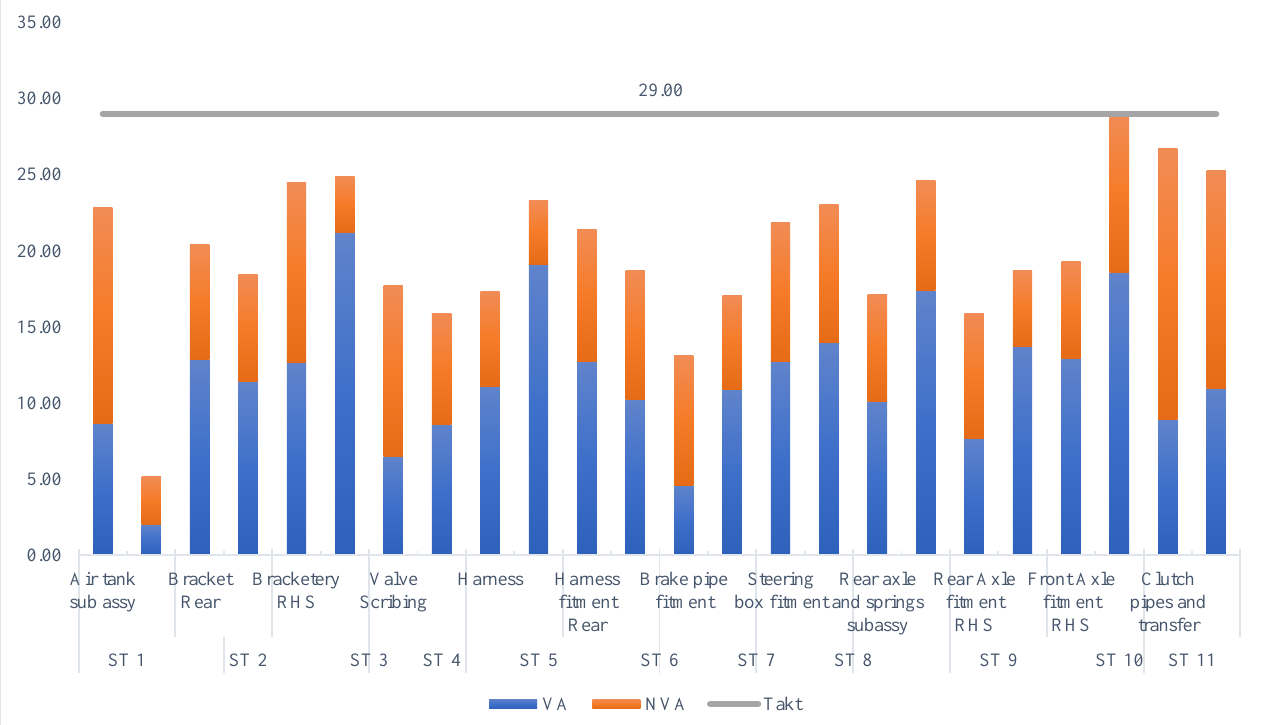
Figure 2. Initial state of the production line balancing of truck manufacturing industry (VA – value added times; NVA – Non-value-added times; Takt time-metric for production time determina- tion).